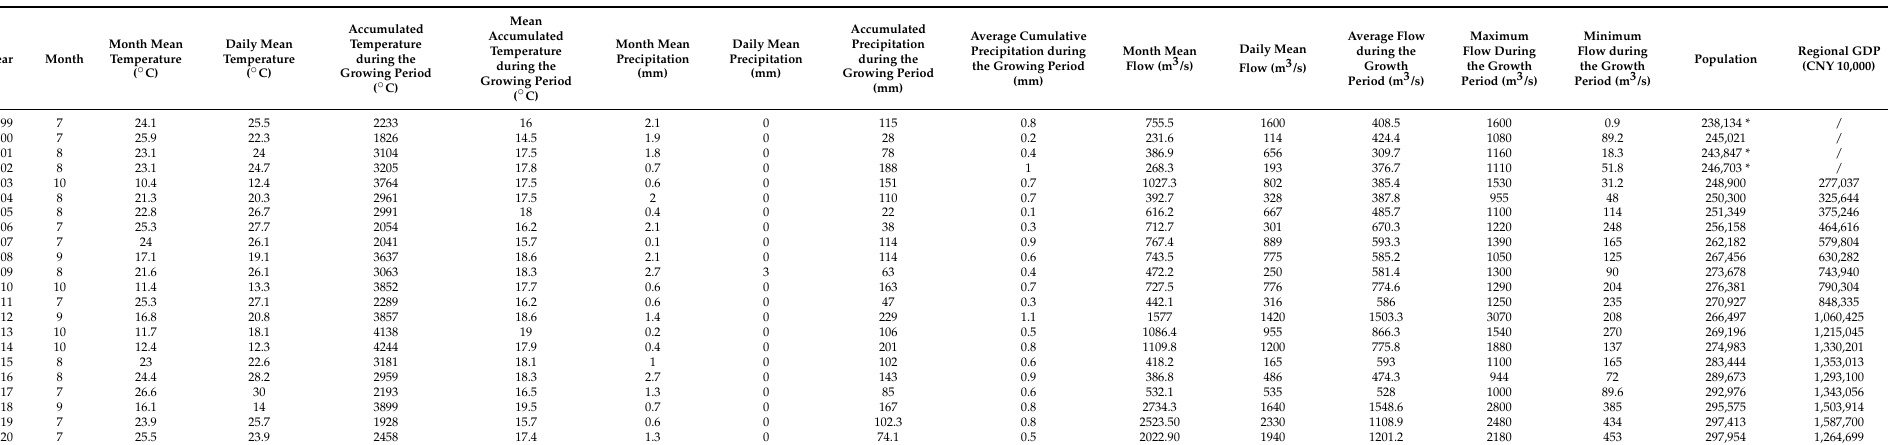
Table 1. Basic statistics on natural and economic